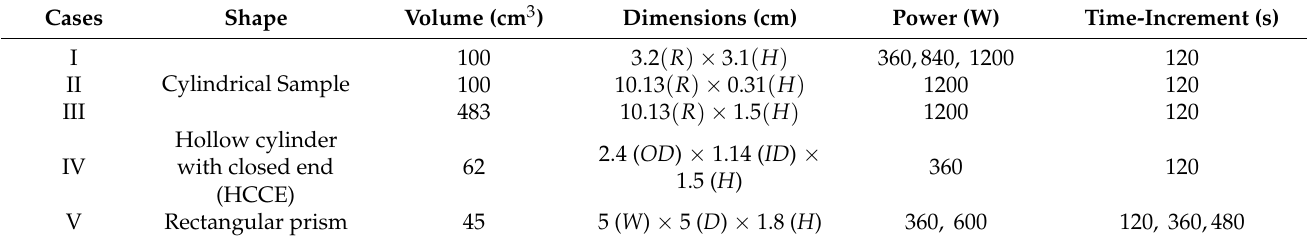
Table 3. Drying modeling scenarios used to evaluate microwave drying modeling